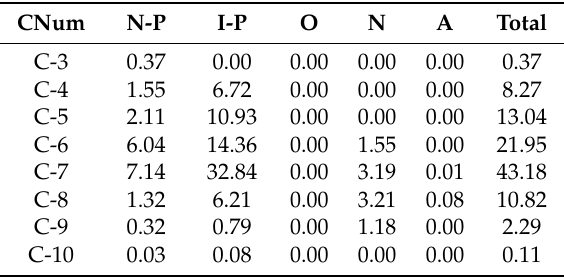
Table 5. The product of light naphtha Isomerization (48 h).